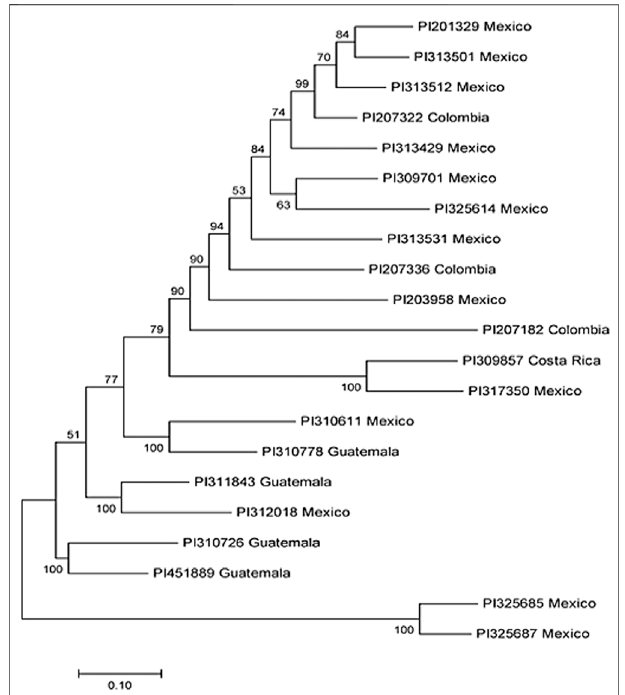
MLM QQ-plot obtained from the cMLM analysis from GAPIT and the MLM analysis from FarmCPU, and BLINK. The QQ- plots obtained from GAPIT, BLINK, and FarmCPU showed a larger divergence between the observed vs. expected values at LOD > 2.5 ( Supplementary Figure S4 ). This indicates the to the BW isolate 557 ( Supplementary Figure S4 ).